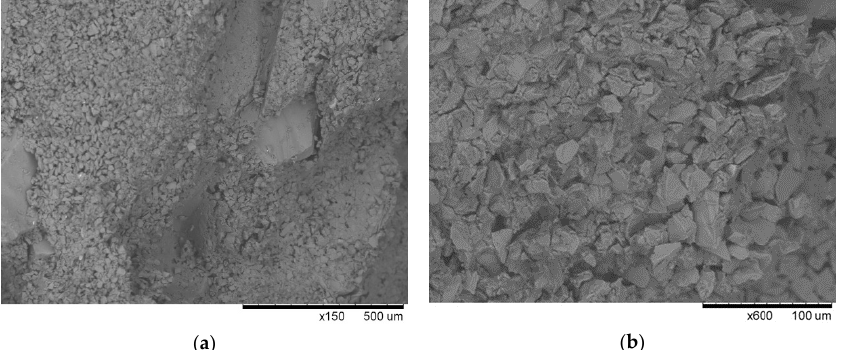
Figure 19. Example tomogram of SiC 1200 °C sample cross section. Figure 20. SEM morphology of PW1 sample cross section: ( a ) ×150; ( b ) ×600.